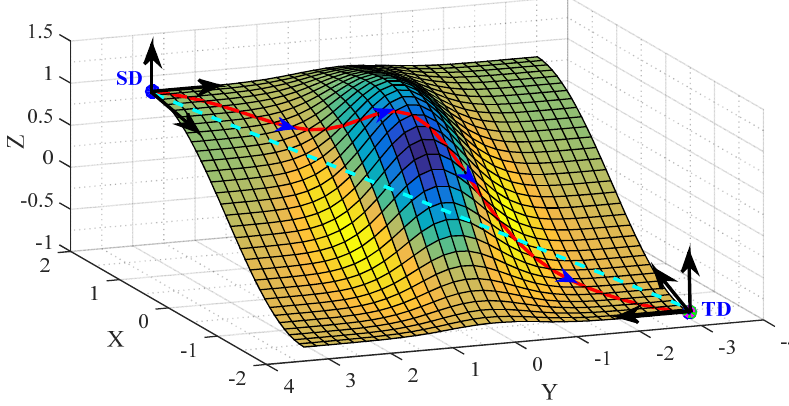
Figure 1. Illustration of the main idea of geodesic flow for domain adaptation.